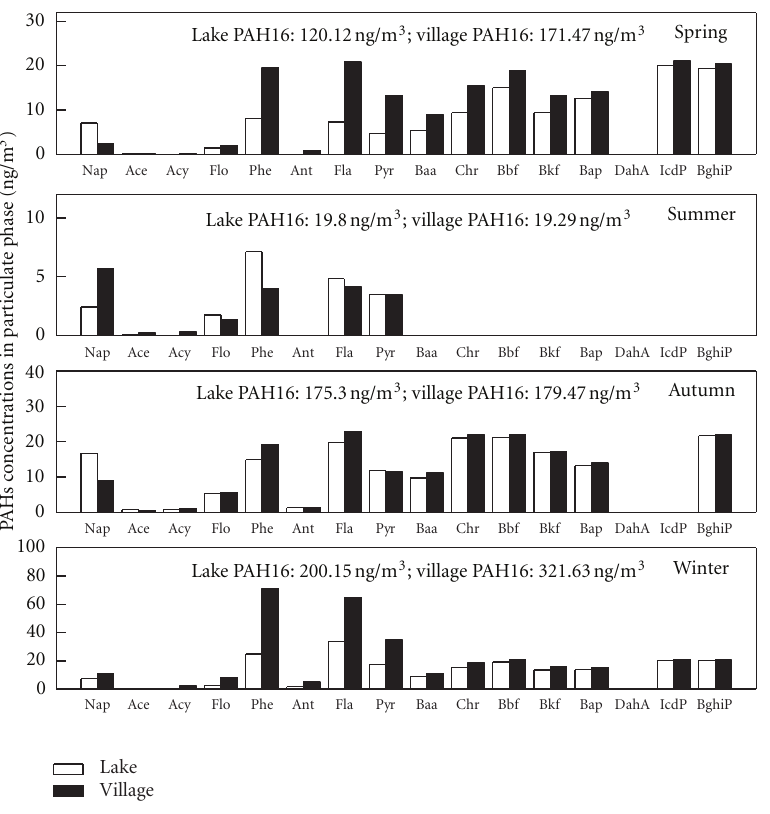
Figure 3: Seasonal-spatial variation in PAHs in the particulate phase at Lake Small Baiyangdian.